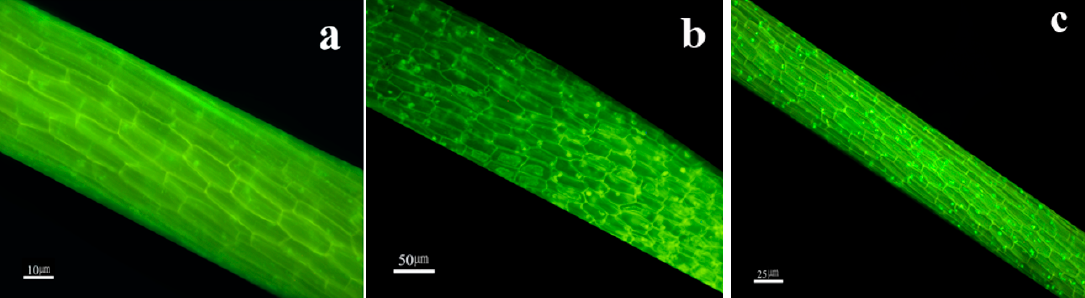
Figure 2. Fluorescence microscopic images of L. minor roots ( a ) control, ( b ) treated plants with 40 mg L − 1 CdSe NPs, ( c ) treated plants with 80 mg L − 1 CdSe NPs. Distinguished shiny green marks present nanoparticles.